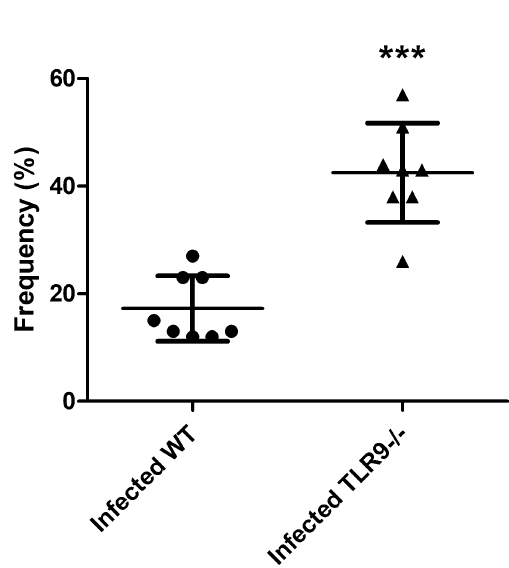
Figure 4. Percentage of titan cells in the lung of C. gattii -infected mice. Titan cell (> 10 µm cell size) counts per 100 yeast cells observed in defined quadrants in the histological sections of the lungs of WT (n = 3) and TLR9 −/− (n = 4) mice after 21 days of C. gattii infection. Each lung (right and left) was divided into two